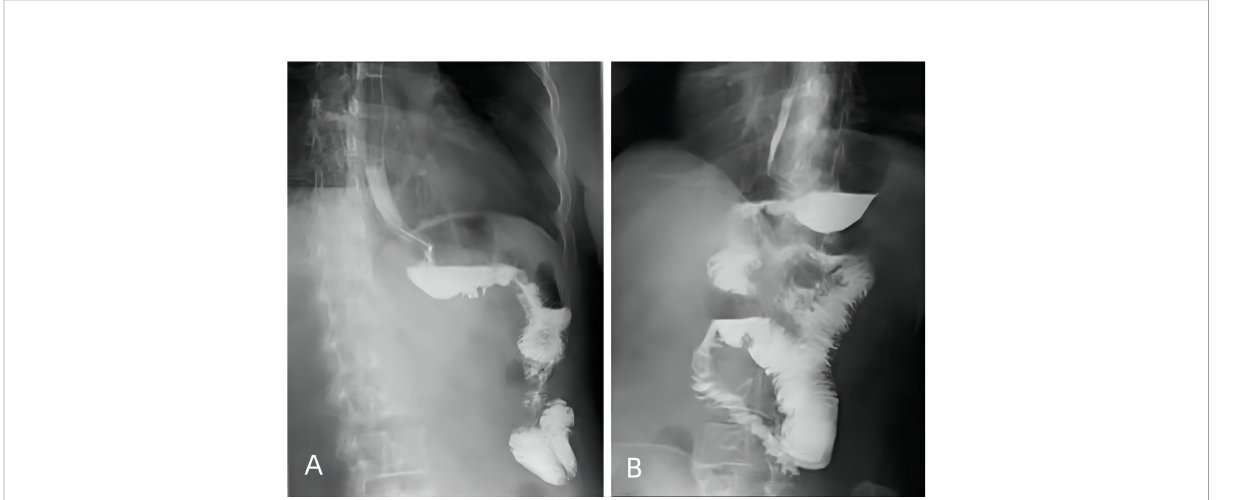
FIGURE 3 Upper gastrointestinal water-soluble contrast radiography performed 3 days after SPLT-RY in TLDG. (A) Anastomosis of the proximal stomach and distal jejunum. (B) Anastomosis of the small intestine and proximal jejunum. SPLT-RY, self-pulling and latter transected Roux-en-Y; TLDG, total laparoscopic distal